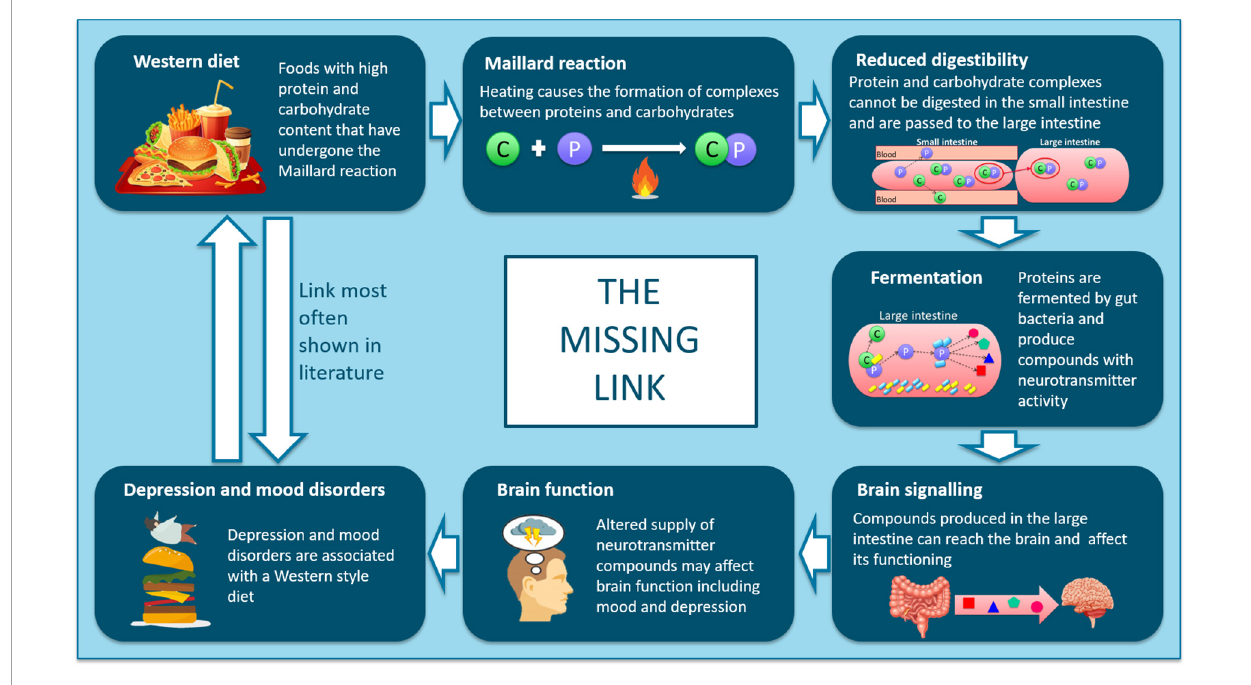
FIGURE6 Schematic showing the proposed mechanisms linking intake of ultra-processed, resistant protein-containing foods with outcomes relating to depression and mood disorders.